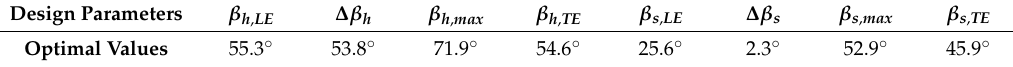
Table 4. Optimal values of the beta distribution.